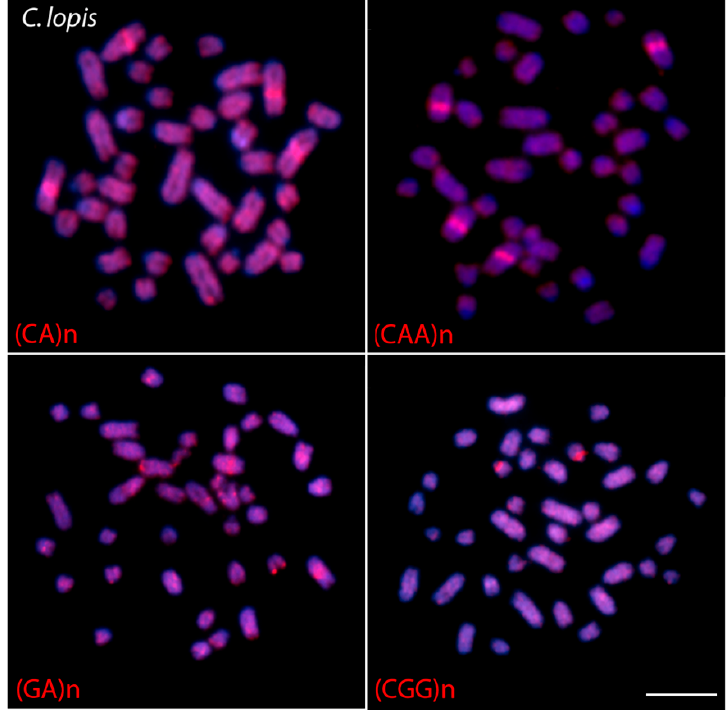
Figure 6. Metaphase chromosomes of C. lopis hybridized with different labeled microsatellite- containing oligonucleotides. Scale bar = 5 μ m.